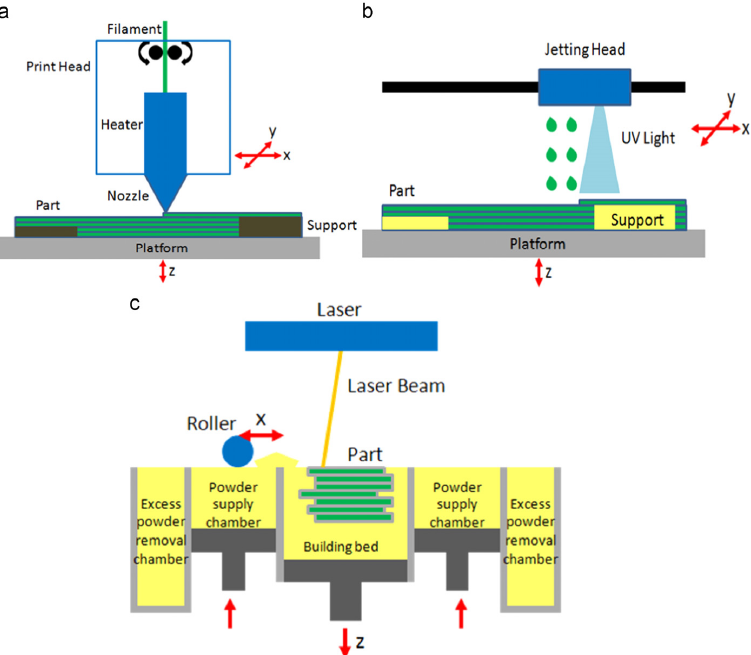
Figure 13. ( a ) Solid-based, ( b ) liquid-based and ( c ) powder-based 3D printing technologies. Re- printed from [174] with permission from Elsevier, 2016. from [174] with permission from Elsevier,